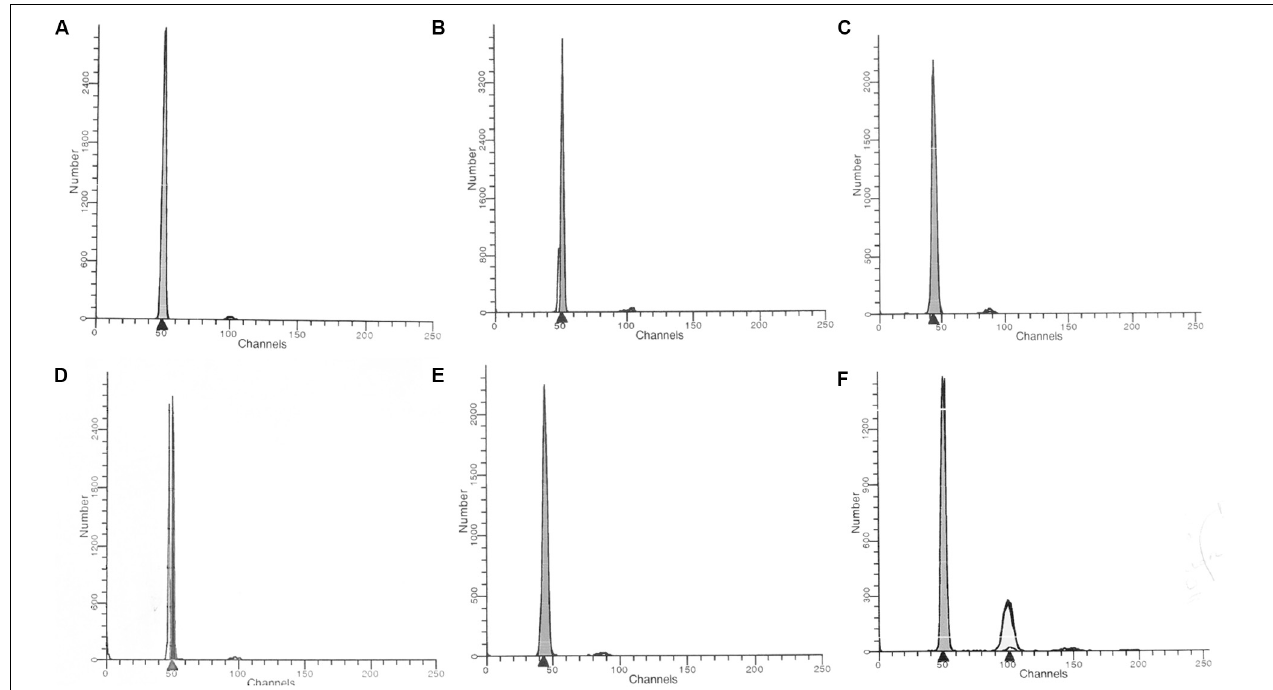
FIGURE 1 | Unidimensional histogram in linear scale obtained by flow cytometry. (A) healthy control; (B) HTLV-1 infected hyperdiploidy; (C) HTLV-1 infected hypodiploidy; (D) ATL hyperdiploidy; (E) ATL hypodiploidy; (F) ATL hyperdiploidy (tetraploidy).